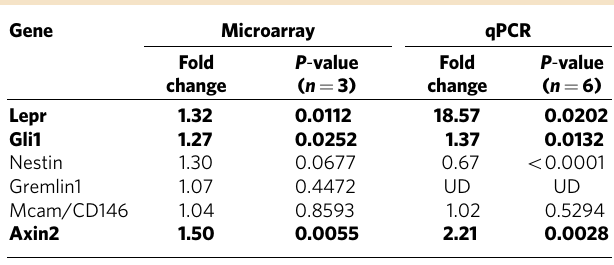
Table 1 | The expression of Lepr and Gli1 is significantly elevated in